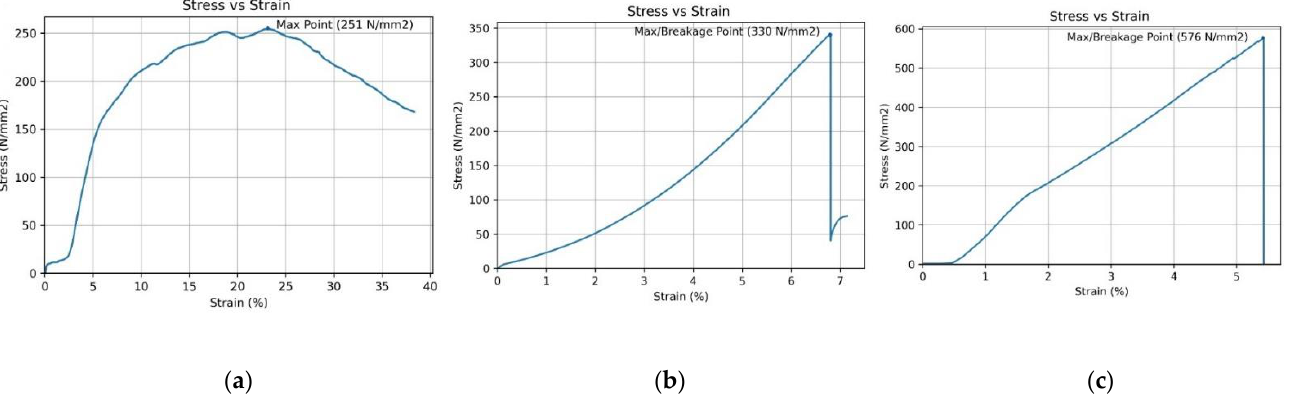
Figure 4. ( a ) Stress–strain Curve for Sample 1 ( b ) Stress–strain Curve for Sample 2 ( c ) Stress–strain Curve for Sample 3.